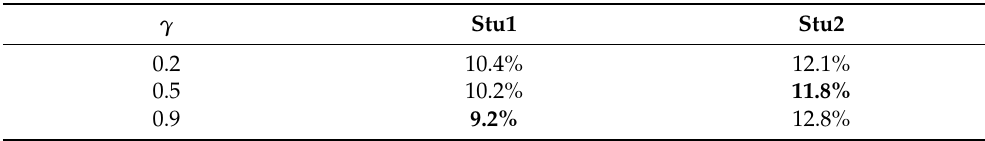
Table 6. The effect of γ in MKD when p = 0.5.